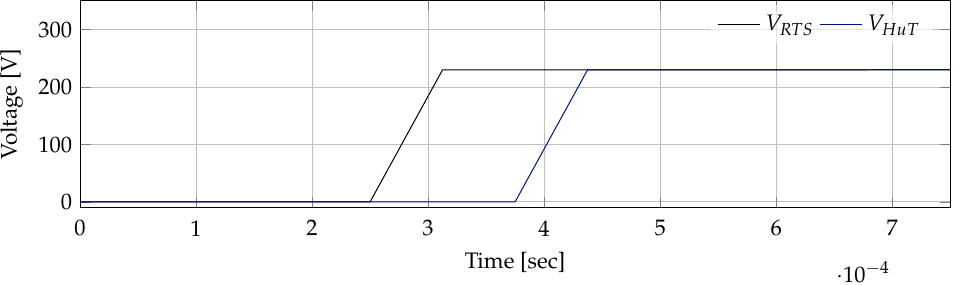
Figure 19. Step response of the linear